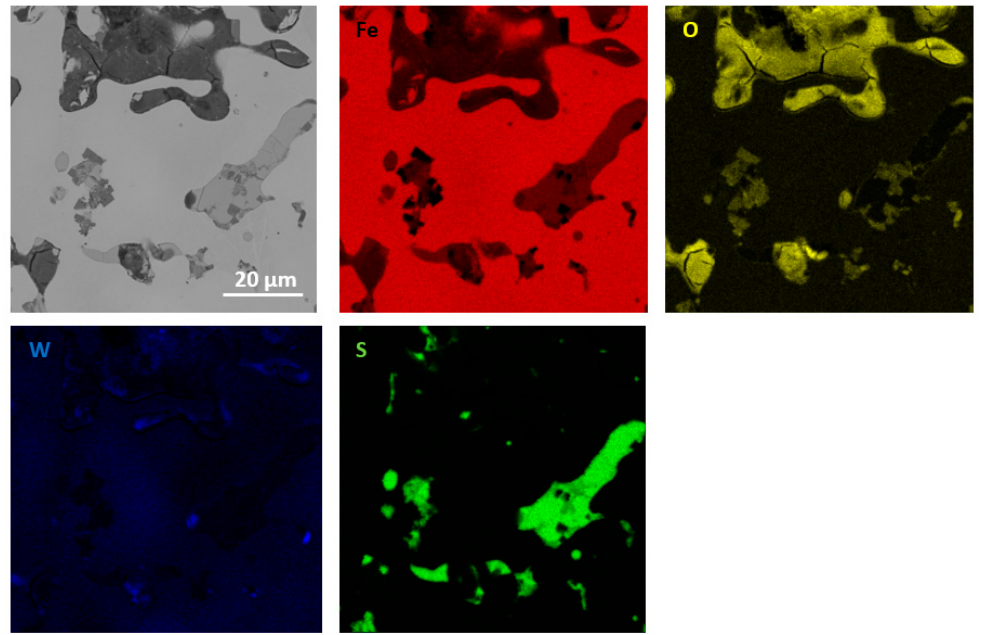
Figure 10. EDS mapping of sintered Fe with the addition of WS 2 with a size of 0.6 µ m (for pressing pressure 250 MPa). Table 5. EDS point analysis of a sintered Fe sample (for pressing pressure 350 MPa) containing 2.5% WS 2 with a grain size of 0.6 μ m.